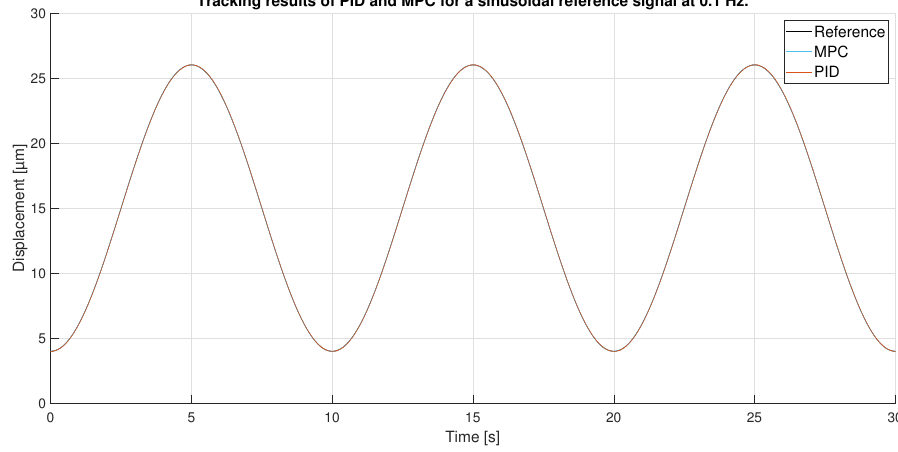
Figure 14. Tracking results of PID and MPC for a sinusoidal reference signal at 0.1